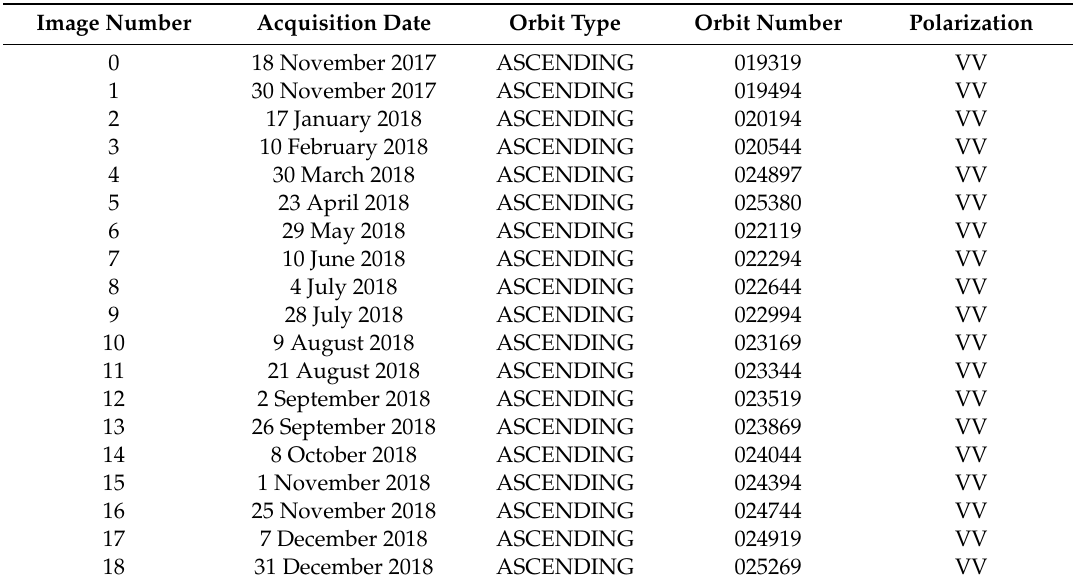
Table 2. Parameters of the 19 Sentinel-1A images used in this study.